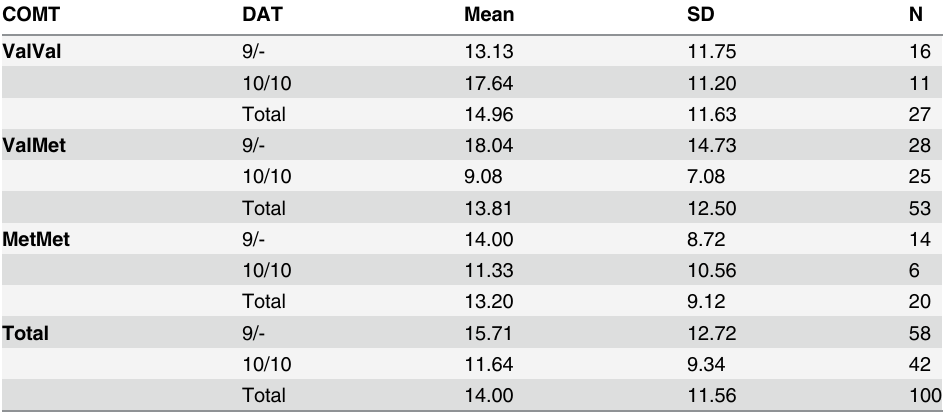
Table 3. Creative Achievement (CAQ) total score means and standard deviations for the COMT and DAT groups. COMT DAT